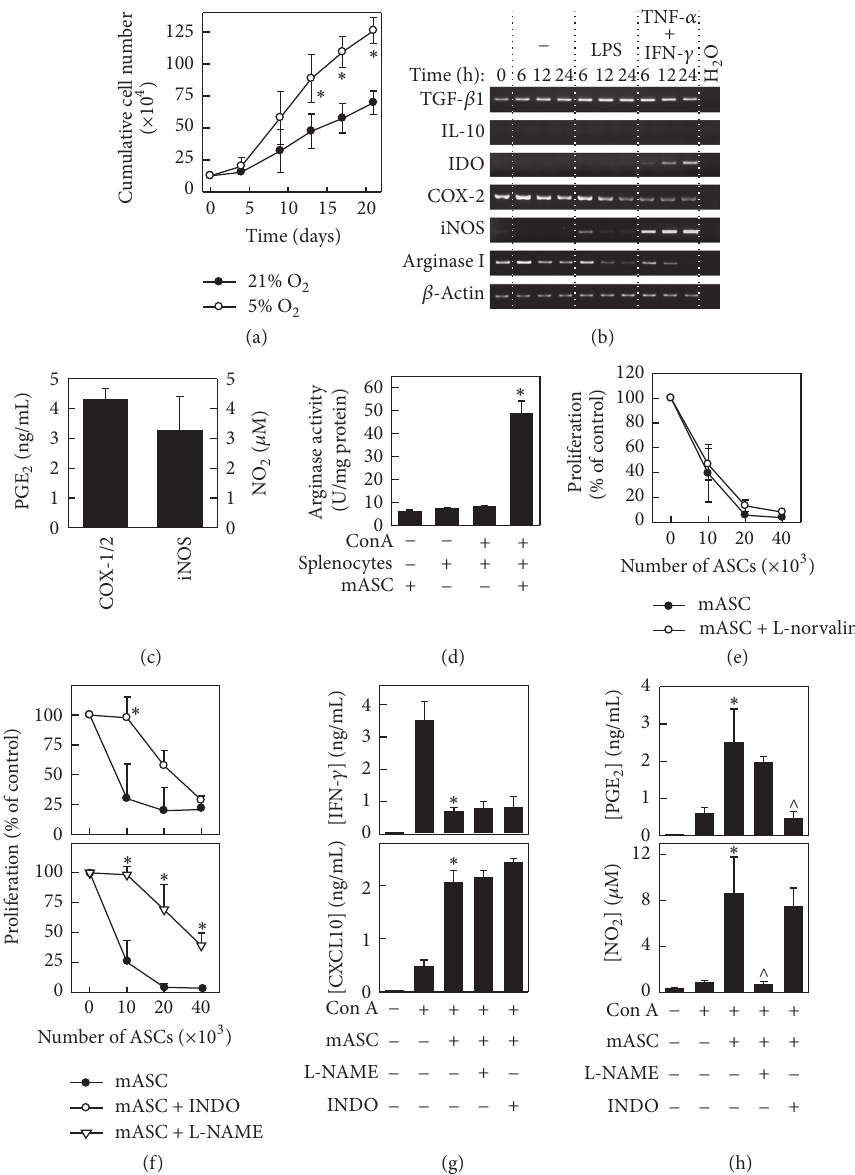
Figure 1: mASCs expanded in hypoxia maintain their immunosuppressive activities. (a) Proliferative response of mASCs expanded in normoxia (21% O 2 ) or in hypoxia (5% O 2 ). mASCs were seeded at 5000 cells/cm 2 in T25 flasks and counted at different time points when reaching 70–80% of confluence. Data are shown as mean (SD) of one representative experiment out of three. ∗ 𝑝 < 0.05 versus 21% O 2 . ((b) and (c)) Immune phenotypic characterization of mASCs. mASCs were expanded under hypoxic conditions and then cultured with medium (unstimulated) or stimulated with LPS (1 𝜇 g/mL) or TNF- 𝛼 (10ng/mL) and IFN- 𝛾 (10ng/mL) for different time points (24 hours for NO 2 determination). Gene expression of different immune markers was analyzed using semiquantitative PCR. iNOS activity was measured in TNF- 𝛼 /IFN- 𝛾 -stimulated mASCs by the detection of NO 2 in culture supernatants using Griess assay. COX-1/2 activity was determined by measuring the PGE 2 levels in culture supernatants from unstimulated mASCs. (d) Arginase activity is induced in mASC: splenocyte cocultures.SplenocyteswereculturedwithorwithoutmASCsandstimulatedwithConAfor3days.Definedquantitiesofcelllysateswerethen subjected to an in vitro arginase activity assay. Data are shown as mean (SEM) of 3 independent experiments. ∗ 𝑝 < 0.05 versus splenocytes + ConA. ((e), (f), and (g)) mASCs suppress T cell proliferation in vitro via iNOS and COX-1/2 but not arginase activity. Splenocytes (10 6 cells/mL) were stimulated with ConA (2.5 𝜇 g/mL) in the presence of different numbers of mitomycin C-treated mASCs (ratio 20 :1 for IFN- 𝛾 and CXCL10 determination). ((e) and (f)) The iNOS inhibitor L-NAME (1mM), the COX-1/2 inhibitor indomethacin (20 𝜇 M), and the arginase inhibitor L-norvaline (10mM) were added to cultures when indicated. After 3 days, cell proliferation was measured by [ 3 H]- thymidine incorporation and (g) IFN- 𝛾 and CXCL10 contents in the supernatants were determined by ELISA. Data are shown as mean (SEM) of 3 independent experiments. ∗ 𝑝 < 0.05 versus mASC in (f) and ∗ 𝑝 < 0.05 versus ConA in (g). (h) iNOS and COX-2 activities are increased in mASC: splenocyte cocultures. ConA-stimulated splenocytes (10 6 cells/mL) were cultured with mitomycin C-treated mASCs (ratio 20 :1) in the presence of L-NAME or indomethacin for 3 days and the PGE 2 and NO 2 contents measured in the culture supernatants. Results are shown as mean (SEM) of 3 separate experiments. ∗ 𝑝 < 0.05 versus ConA; ∧ 𝑝 < 0.05 versus mASC +